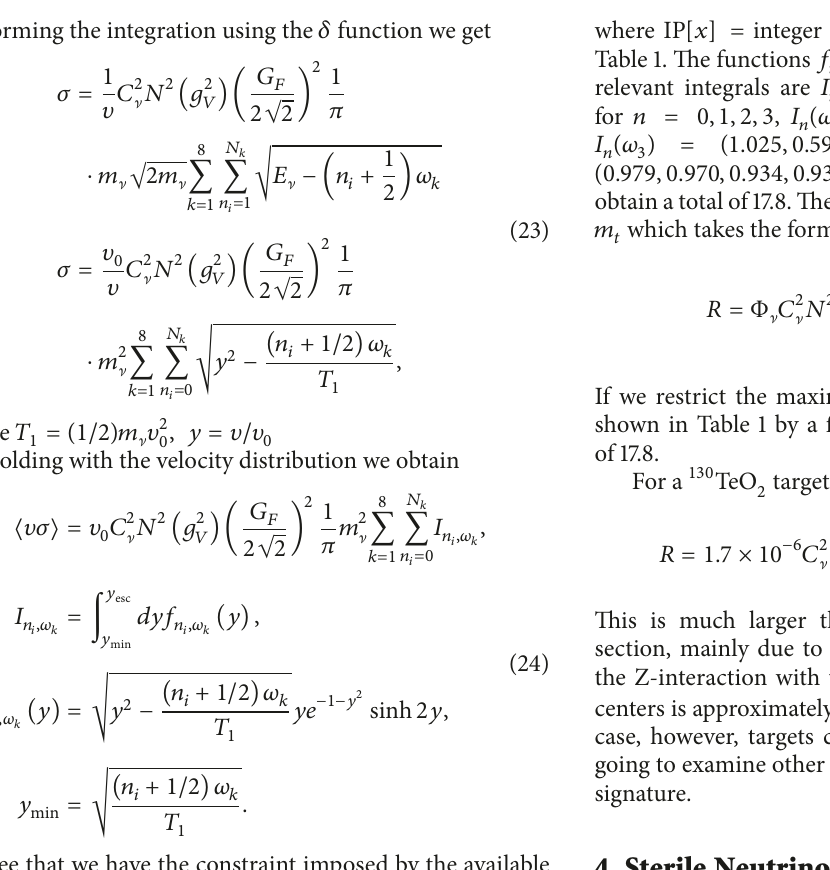
(𝑦) ,exhibitedasafunctionof 𝑦 ,associatedwiththemode ] 1 (𝑦) associated with ] = 124 cm −1 for 𝑛 = 0,1 and 𝑓 2 2